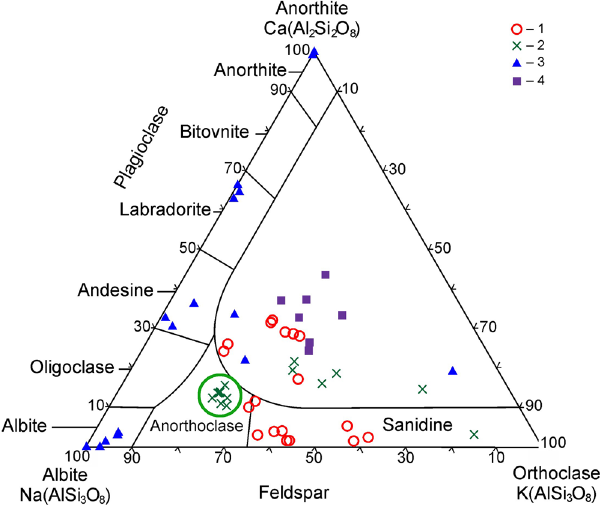
Figure 3. The feldspar ternary diagram of compositions of clastogenic impact glasses from suevites and UHPHT vein-like glasses of the Kara and Ries astroblemes: 1 – Anaroga river; 2 – Kara river; 3 – Sopchau river;